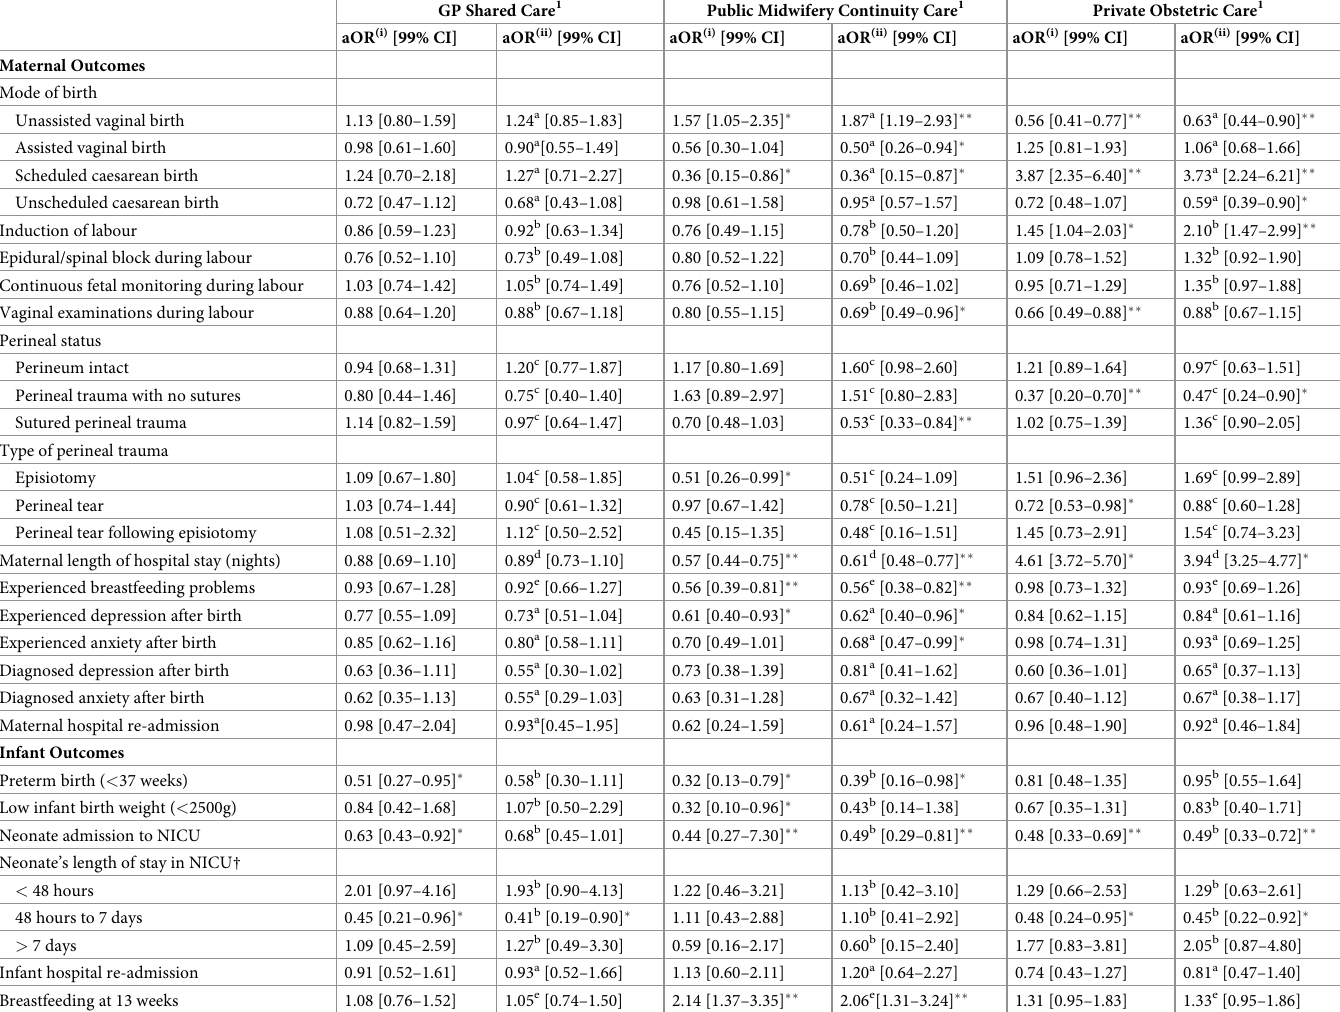
Table 4. Adjusted odds ratios for obstetric interventions and maternal and infant health outcomes by maternity model of care, adjusting for (i) sociodemographic characteristics, reproductive history, and (ii) with additional adjustment for relevant clinical